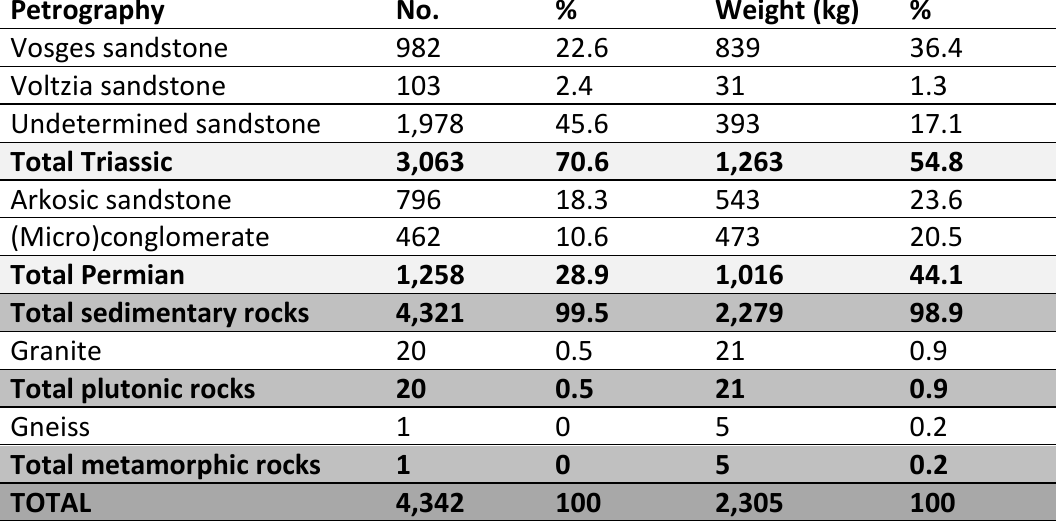
Table 1. Quantitative data of rock procurement at